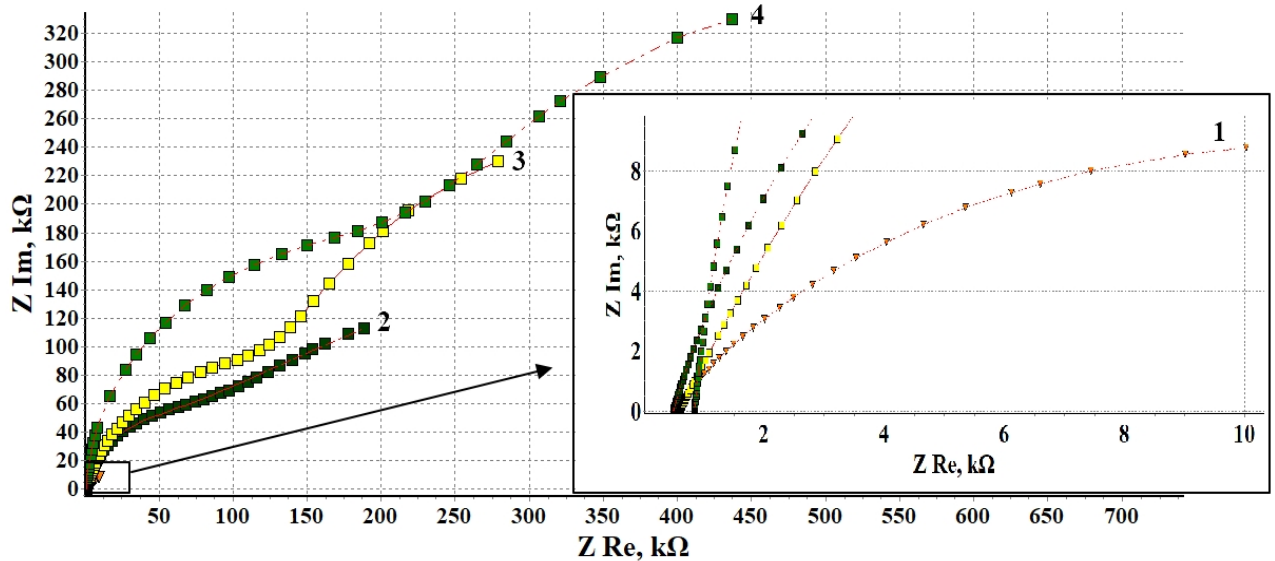
Figure 3. Nyquist diagrams of steel electrode after heat treatment in the absence of a CIN—1, and after CT: 2—BTA, 3—ODA, 4—ODA + BTA .